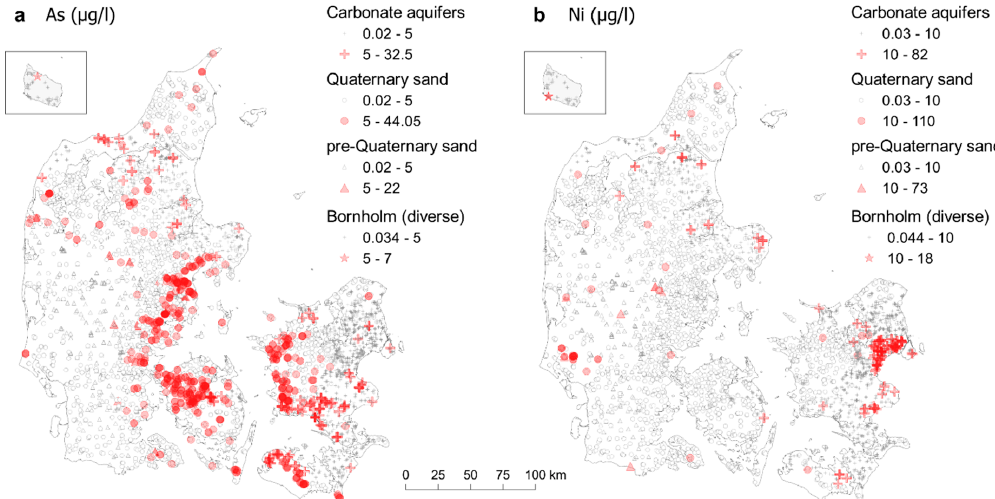
Figure 3. Empirical distribution for As, Cd, Cr, Cu, Ni, and Zn in Danish groundwater at water- works wells used for drinking water production; each point is a median concentration for 2009– 2018 at each sampling point.